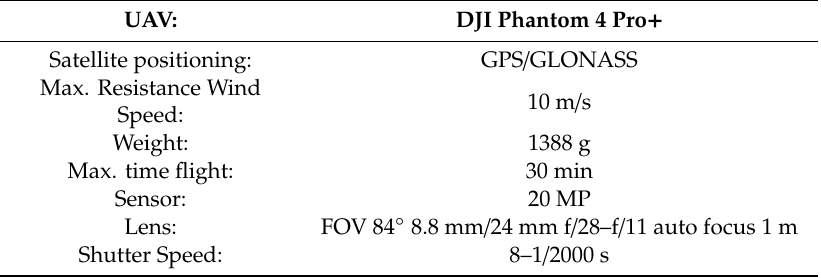
Table 1. Technical specifications unmanned aerial vehicles (UAV) equipment